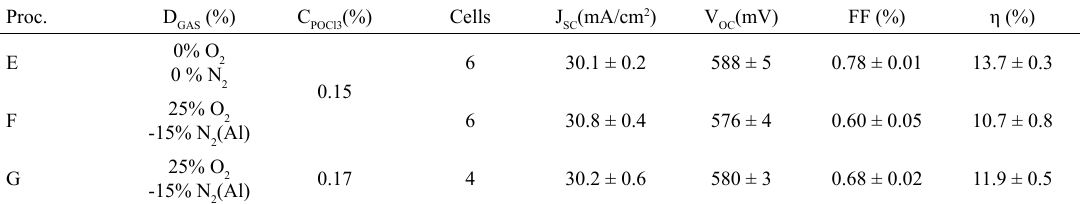
Figure 7. (a) Two-dimensional distribution of the minority carrier diffusion length measured in the best solar cell processed with simultaneous diffusion of aluminum and phosphorus. Figure 5. J-V curve of the solar cells with the highest efficiency, processed with different gas flow and POCl 3 ) during the entrance of the wafers Table 6. Electrical parameters of solar cells as function of oxygen and nitrogen flow variation (D GAS in the quartz tube and Al diffusion, respectively, for aluminum and phosphorus diffusion temperature of 875 °C. The aluminum and phosphorus diffusion time was 90 and 30 minutes, respectively.